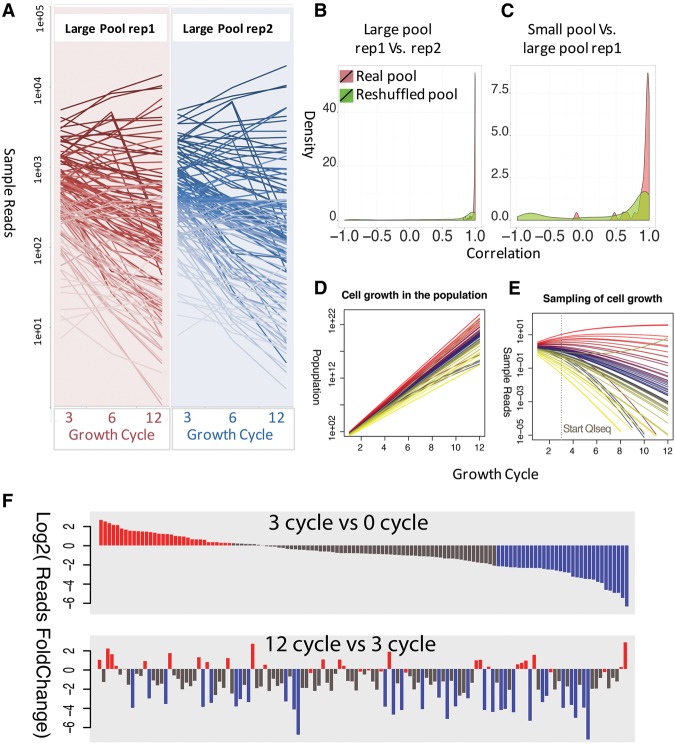
Using QIseq to measure growth of 128 piggyBac mutants in a single pool. (A) Growth of each mutant within two biological replicates (rep1, rep2) of the same pool, grown over 12 cycles. (B) Permutation-based statistical test of reproducibility between replicates and between different screens. (C) The same mutants in different replications always had a significantly higher correlation compared with randomly reshuffled mutant pairs (Wilcoxon test P < 1 × 10−5). (D) Estimates of population growth by individual piggyBac mutants within the pool of clones grown together over 24 cycles. (E) Estimates of QIseq sampling of piggyBac mutant populations. While all piggyBac mutants continue to proliferate, the relative abundance of most slower growing mutants is predicted to decrease (“bottom quartile”) relative to the few faster growing parasites (“top quartile”). (F) Classification of phenotypes from the large pool of 128 mutants identified neutral or advantageous mutations (red; top quartile of growth, N = 32) and deleterious mutations (blue; bottom quartile).